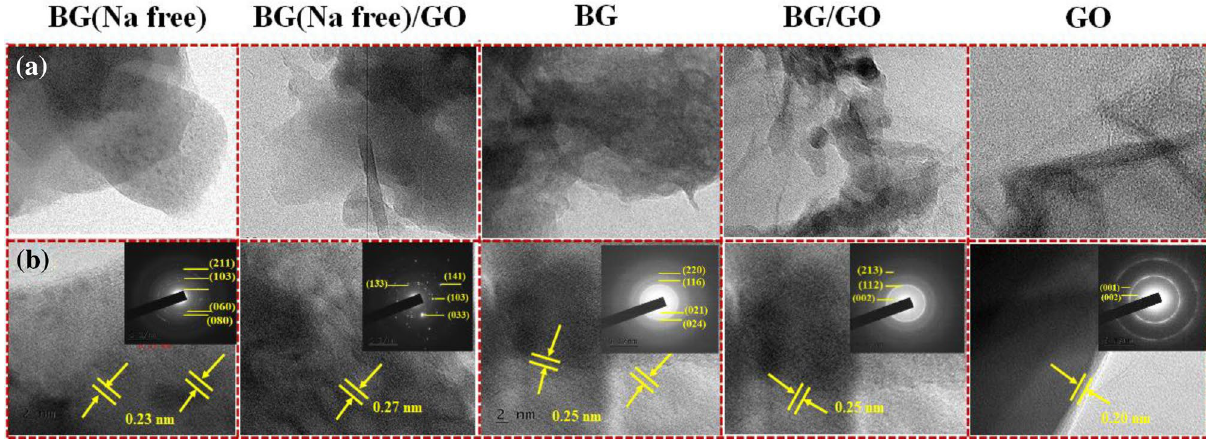
Figure 15. ( a ) HRTEM images of the BG, BG (Na-free), GO, and BG/Na, BG (Na-free)/GO nanocomposites (scale bar: 200 nm), ( b ) corresponding cross-sectional profile (scale bar: 2 nm) at different magnifications, with respective SAED pattern (inset). The arrows show sheet